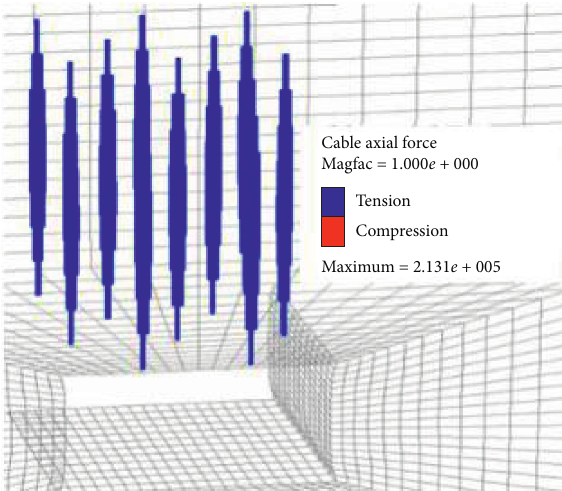
Figure 9: Distribution of axial force of anchor